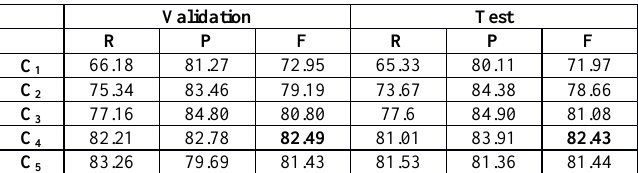
Table 5. Performance of various classifier ensembles.